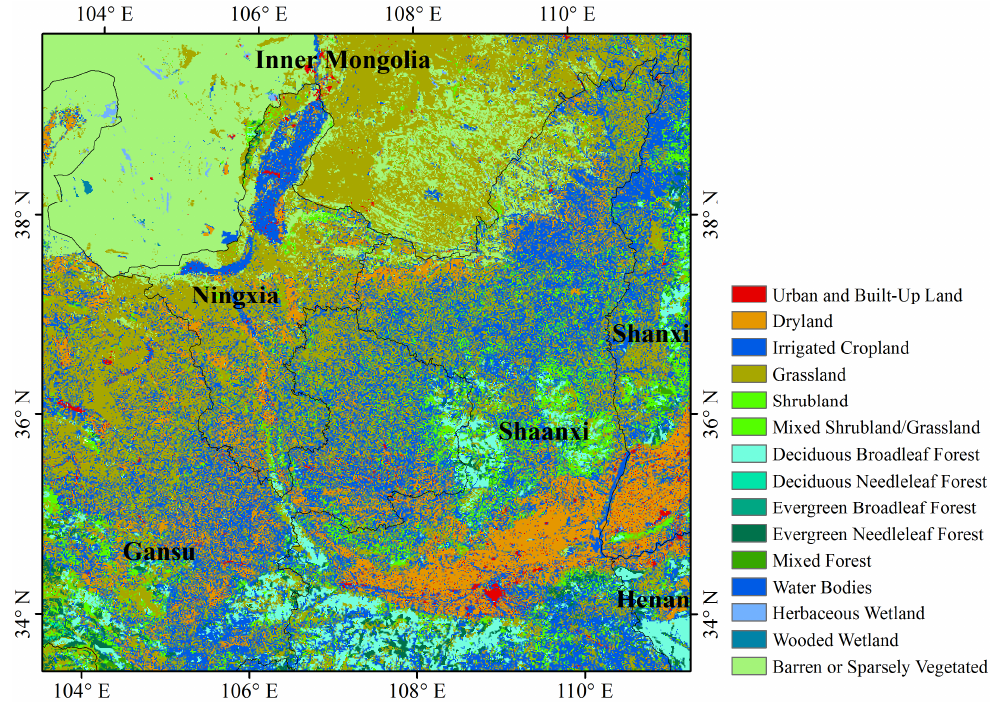
Figure 2. Land cover map of our study area in 2010 represented by the new land cover dataset, with ~1 km spatial